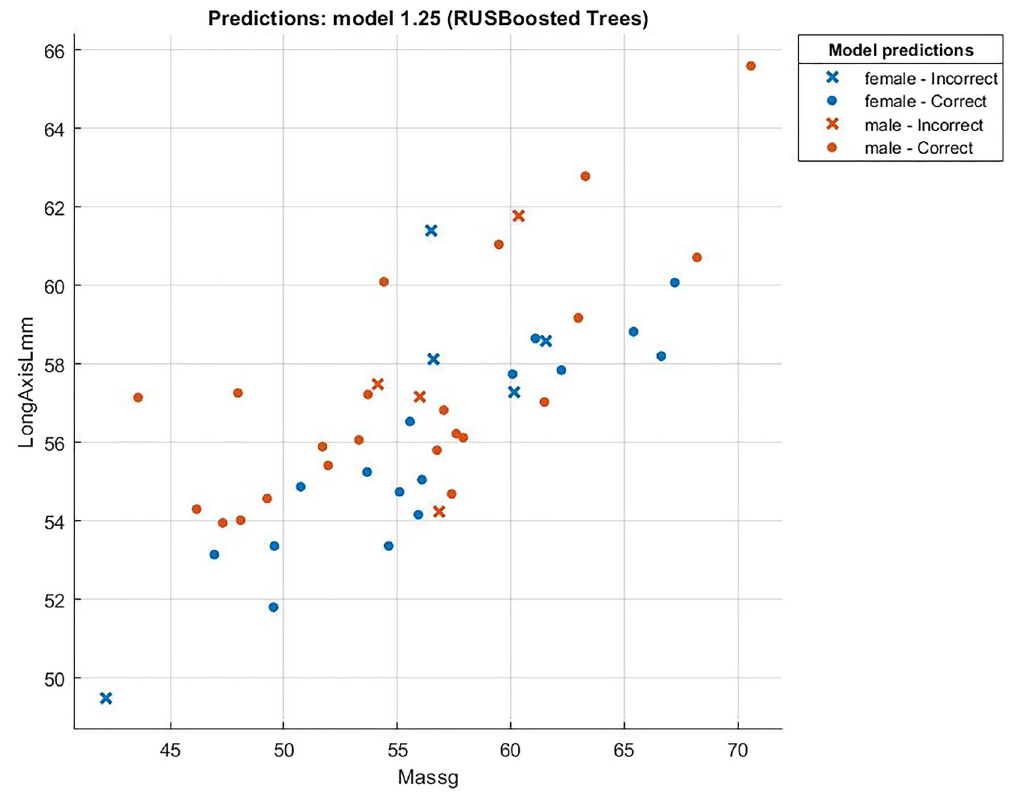
Figure 7. Correlation between mass and long axis (r =